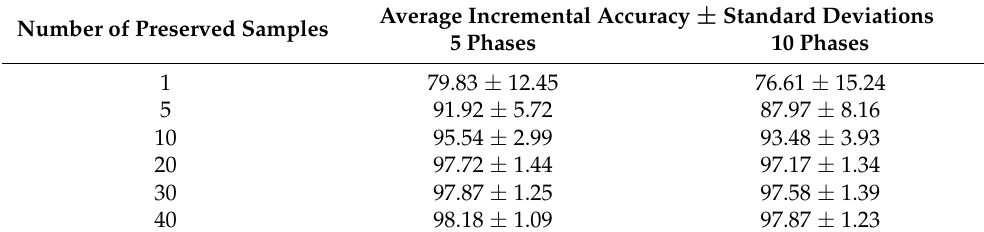
Table 4. Average incremental accuracy for different preserved sample sizes (average incremental accuracy ± standard deviations).